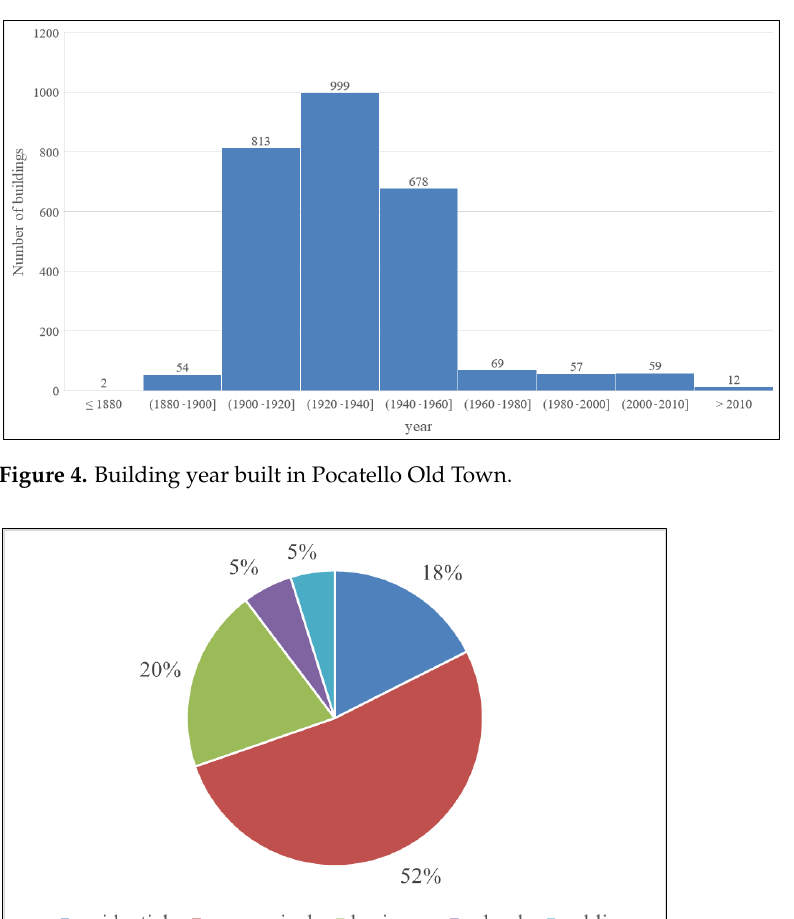
Figure 4. Building year built in Pocatello Old Town.